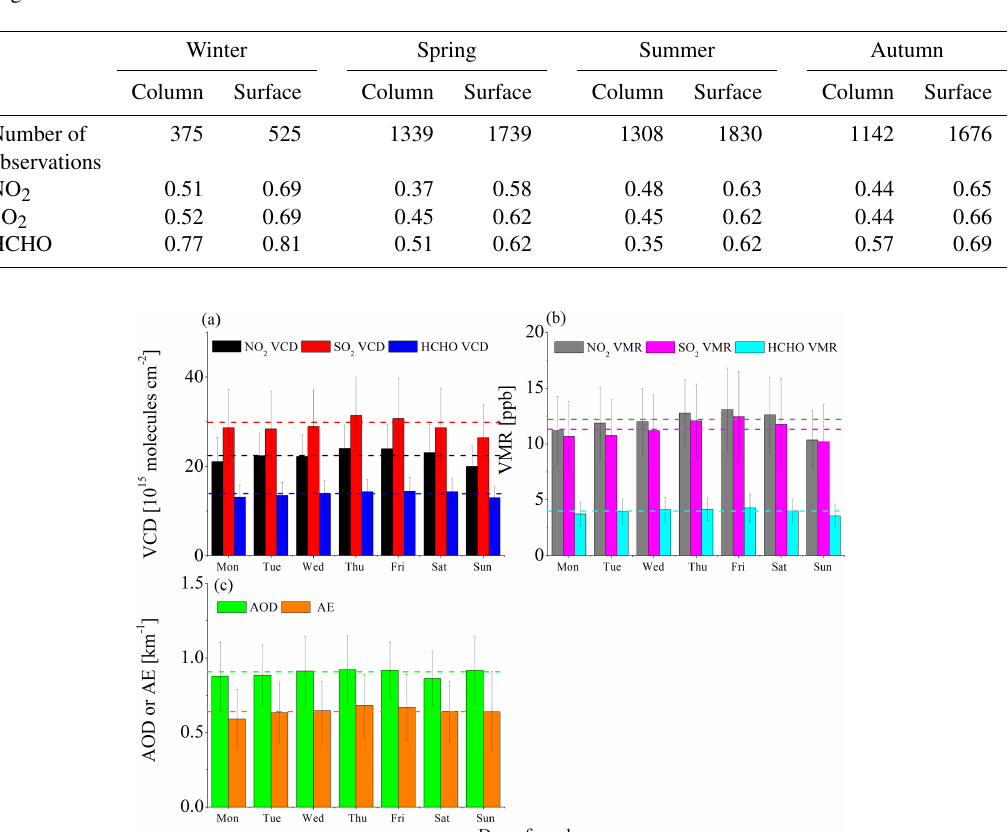
Table 5. Correlation coefficients between hourly averaged trace gas VCDs and AODs (for clear-sky conditions) as well as between VMRs and aerosol extinction near the surface (for clear and cloudy conditions except for thick clouds and fog). The numbers of the data used for the analyses are given for each season.